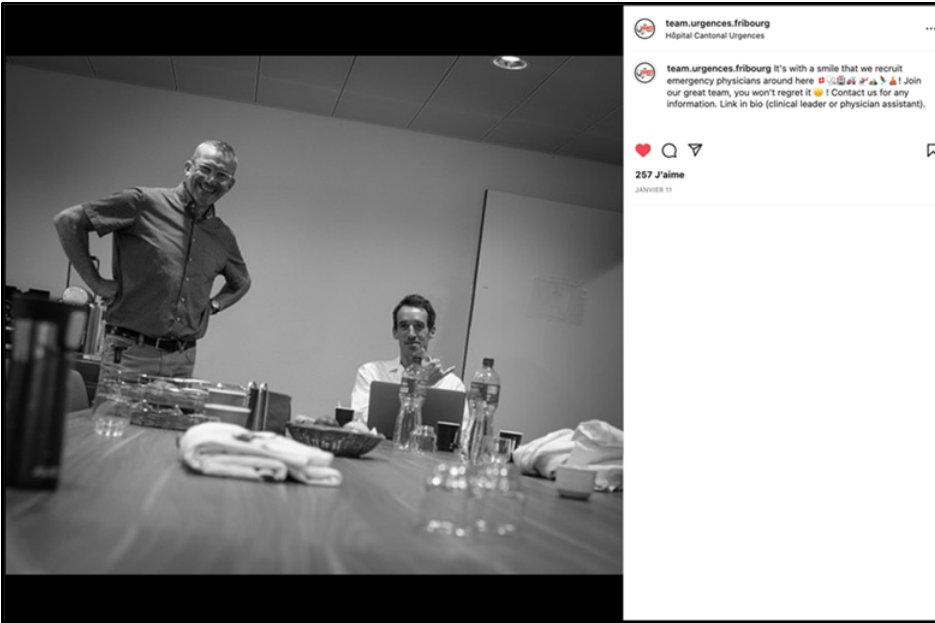
Figure 3. Images of the management team highlighting humanization and personalization of the recruitment process (screenshot).